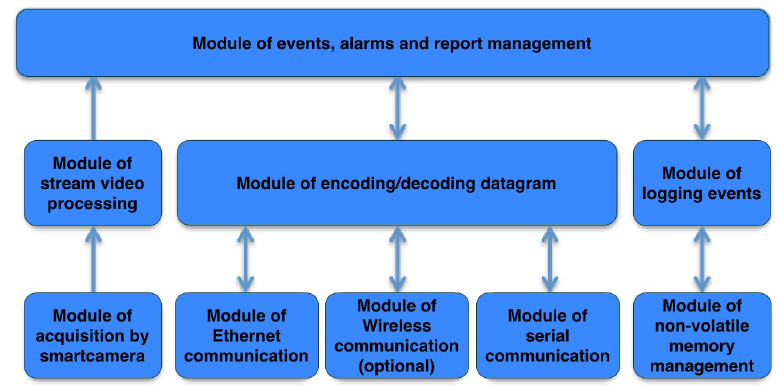
Figure 10. General architecture of the